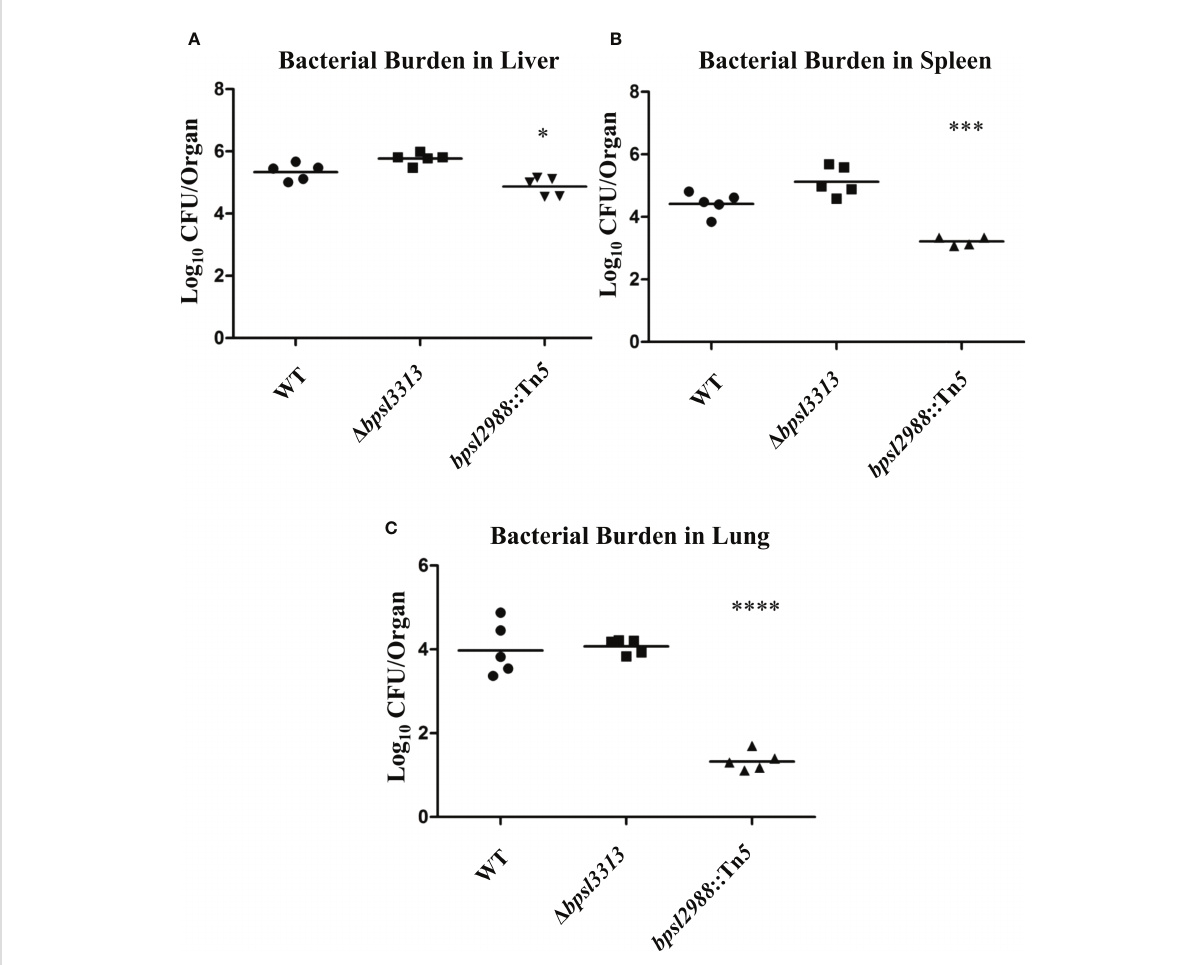
FIGURE 9 Accumulation of B. pseudomallei wild type (WT) and mutants in the (A) livers, (B) spleens and (C) lungs of infected mice at 24 hours post- challenge. Each marker corresponds to the average bacterial CFU (log 10 ) extracted from one infected mouse with horizontal lines signifying the geometric mean. The asterisks represent p values of the WT counts versus the mutants ( t -test, * p <0.05; *** p <0.001; **** p